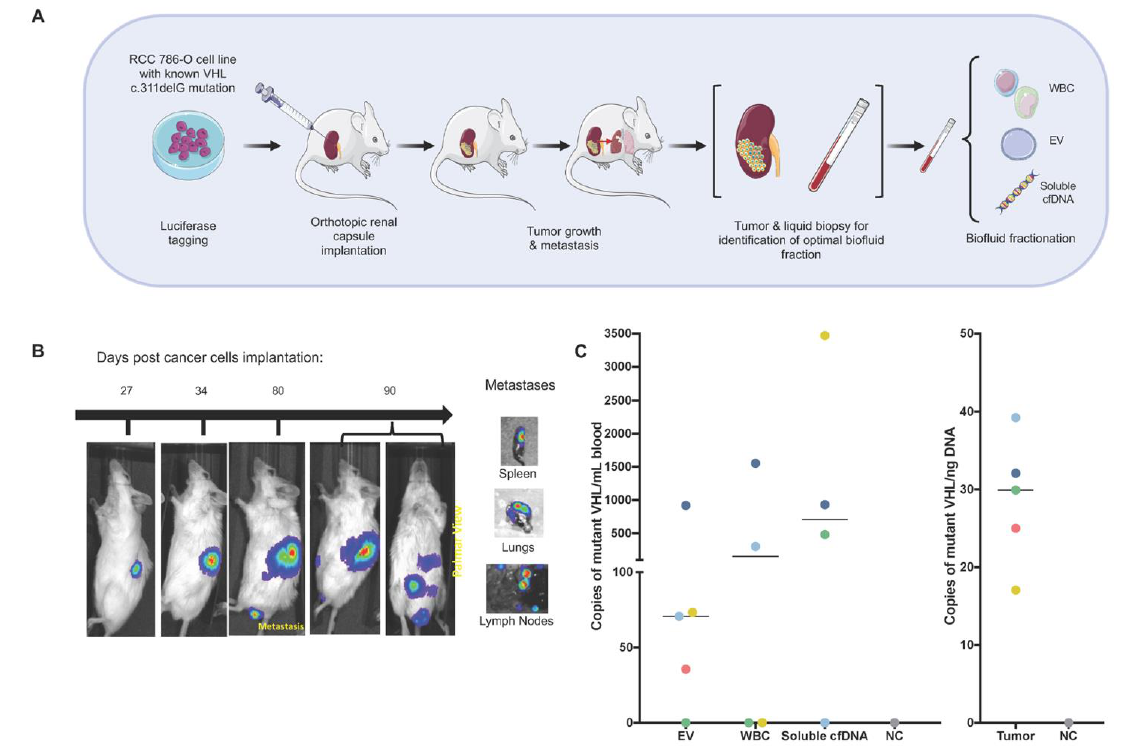
Figure 1. Characterizing the repertoire of ctDNA in RCC. ( A ) Schematic presentation of the in vivo experiments to optimize sample processing for liquid biopsy analysis in RCC. ( B ) Tumor developments in nude mice after orthotropic implantation of 786-O cells. Five mice were implanted, and one animal is shown as an example. Blood samples were drawn after the development of metastatic tumors. ( C ) The presence of the VHL c.311delG mutation in human DNA was interrogated in different blood compartments (left) and in tumor tissues (right) using ddPCR. Each dot represents copy number of mutant allele per mL of blood used for DNA isolation from each animal, or per ng of DNA isolated from tumor tissue. Dot colors represent individual animals. NC: negative control.